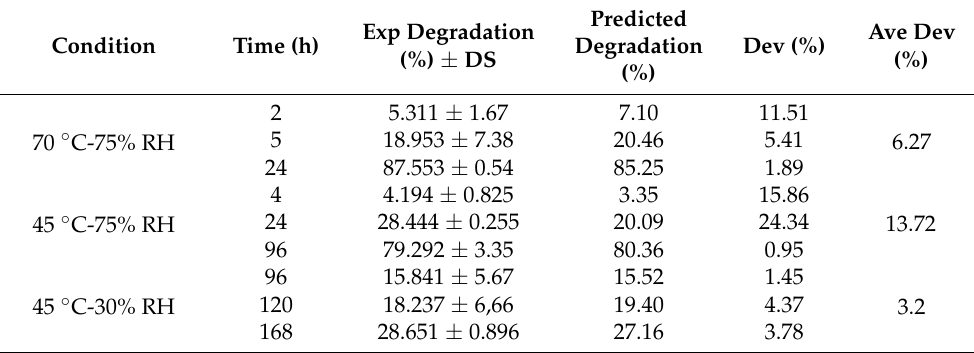
Table 2. Cyanidin-3-O-glucoside (C3G) relative degradations observed after each treatment at the monitored times and their deviation percentage (Dev %) from the predicted values. Average deviations (Ave dev) were calculated for each condition. Exp Degradation was calculated as the mean of all degradation values registered for the three tested batches.